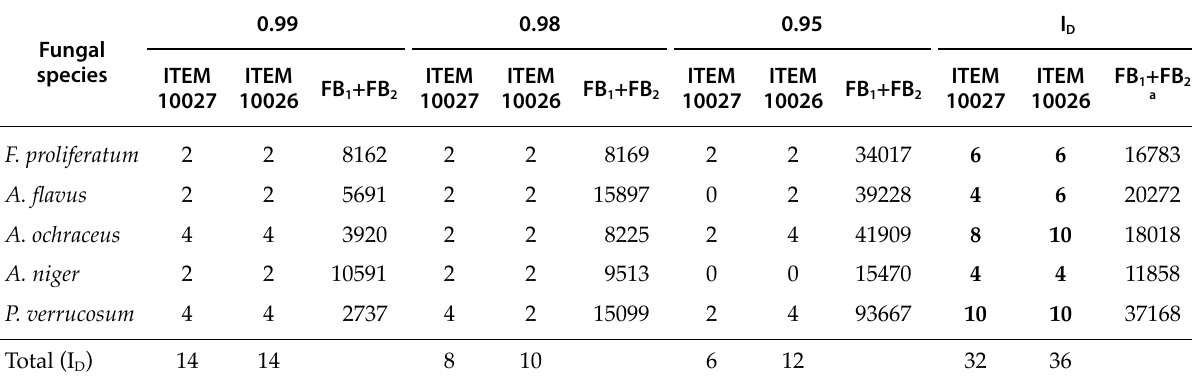
Table 6. Interaction and Index of Dominance (I D ) scores for Fusarium verticillioides (ITEM 10027) and F. verticillioides (ITEM 10026) versus other fungi frequently isolated from maize. Fungi were grown on maize based agar (MA) at three a w condi- tions and incubated at 25°C for 14